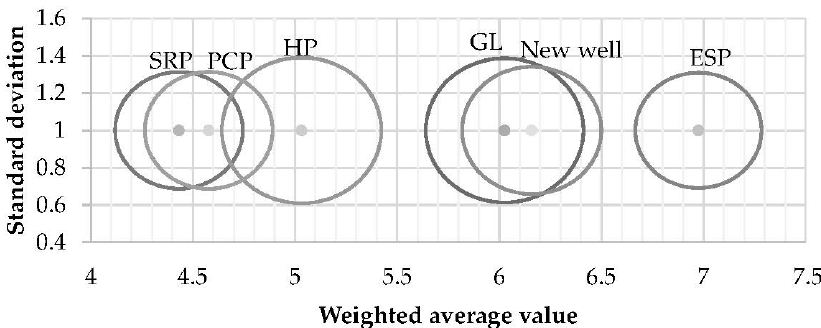
Figure 7. Center of mass and standard deviation outputs for a new well in relation to the standards for the other methods.